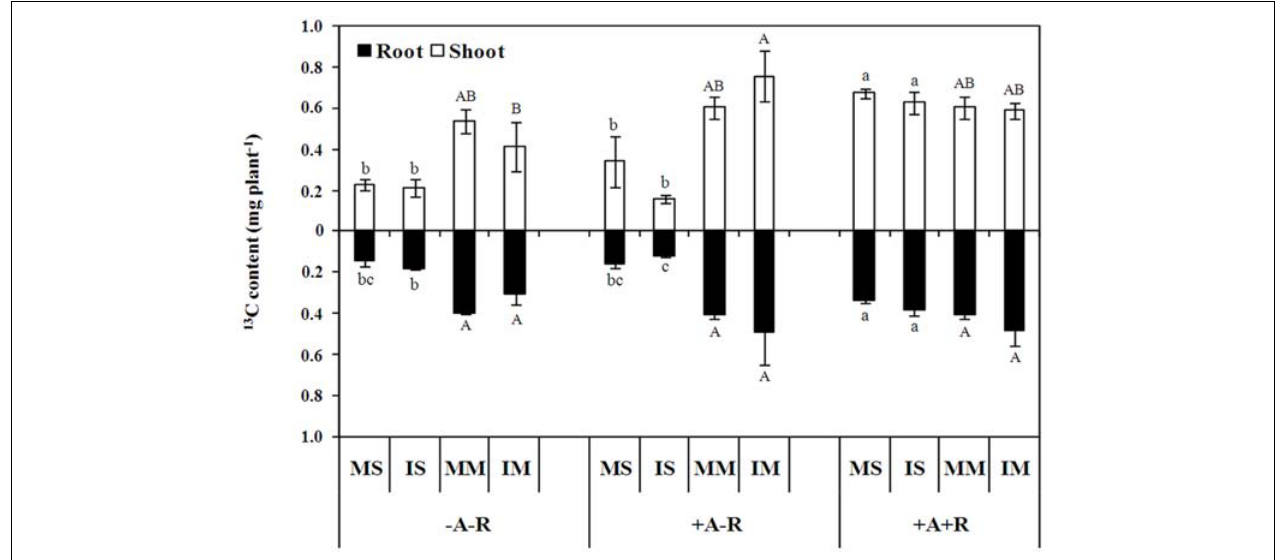
FIGURE 3 | 13 C recovery from shoots and roots of soybean and maize after 6 h labeling under a 13 CO 2 -enriched atmosphere. Data in the figure are the mean of three replicates with standard error. Different letters indicate significant differences among inoculation treatments within a crop species (Duncan’s multiple range test, P < 0.05). MS, monoculture soybean; IS, intercropped soybean. MM, monoculture maize; IM, intercropped maize. − A − R: no inoculation; + A − R: sole inoculation with AMF; + A + R: co-inoculation with AMF and